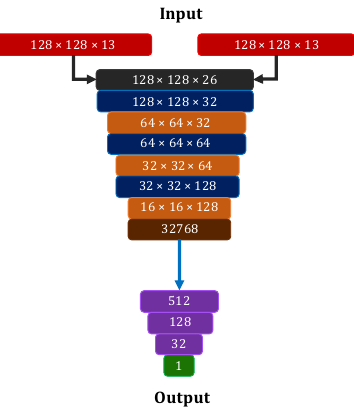
Figure 3. ( Top ) Model architectures used in the change detection task with the segmentation approach. The model on the left adopts the EarlyFusion method, while the model on the right uses the Siamese method. ( Bottom ) Model architecture used in the change detection task with the classification approach, adopting the EarlyFusion method only. Numbers indicate the output size of each layer of the network. Red is for inputs, dark blue for convolutional units, orange for max pooling layers, light blue for transpose convolutional layers, dark gray for concatenation layers, brown for the flatten layer, violet for dense layers, and green for output. Dark gray arrows indicate the concatenation operation, yellow arrows the shared weights and azure arrow corresponds to the batch normalization operation after